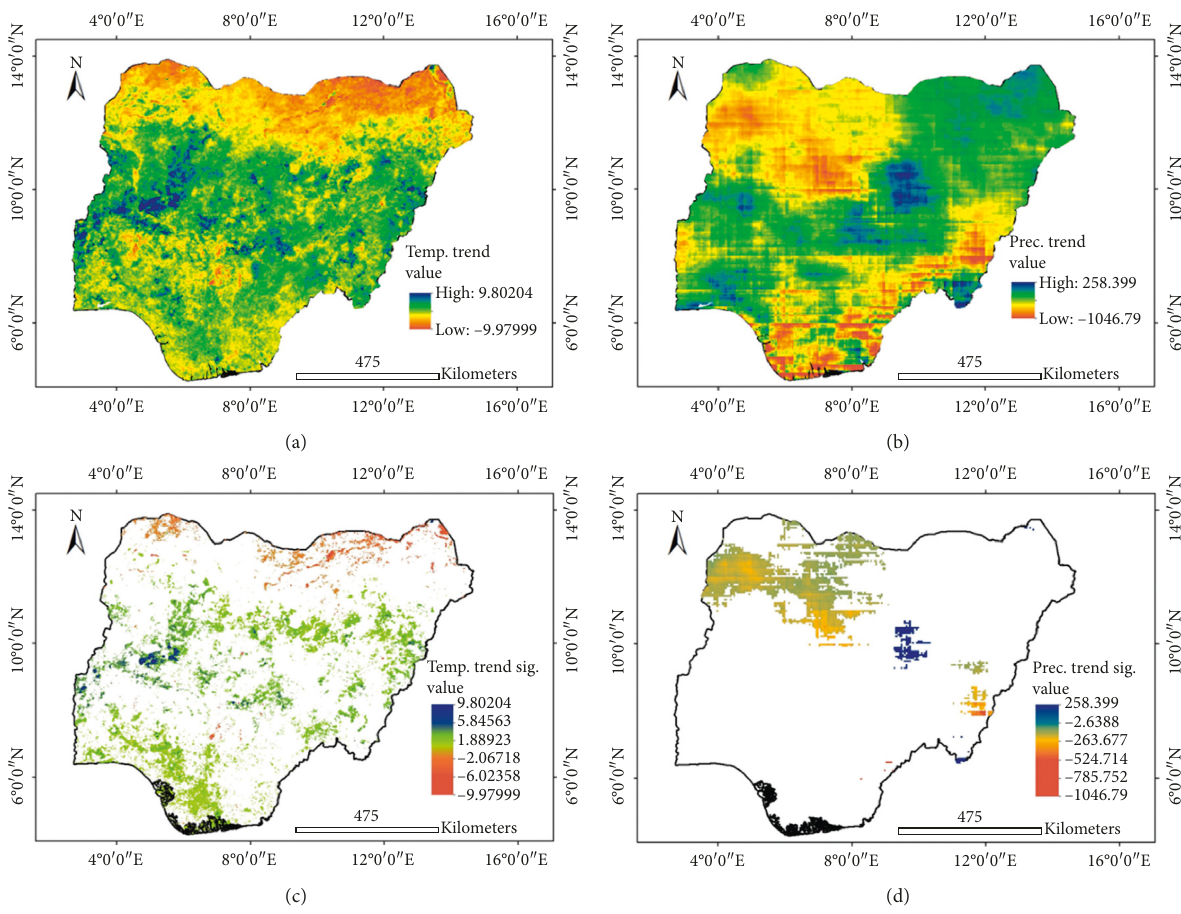
Figure 6: Pattern of rainfall and temperature trends in the study area from 2001 to 2017: (a) mean temperature trends; (b) mean pre- cipitation trends; (c) significant temperature trends; (d) significant precipitation trends.